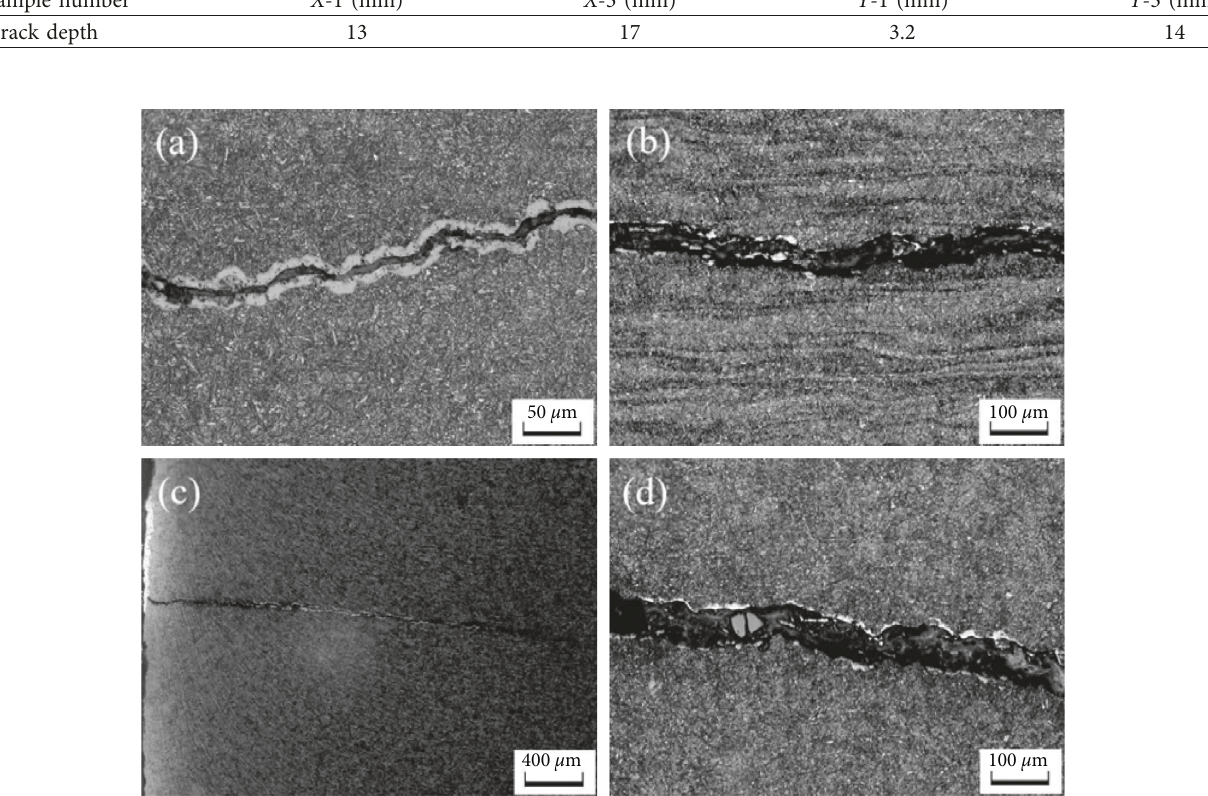
Figure 7: Microstructures on both sides of the crack. (a) Sample X -1. (b) Sample X -3. (c) Sample Y -1. (d) Sample Y -3. Table 5: Inclusion comparison between Steel A and Steel